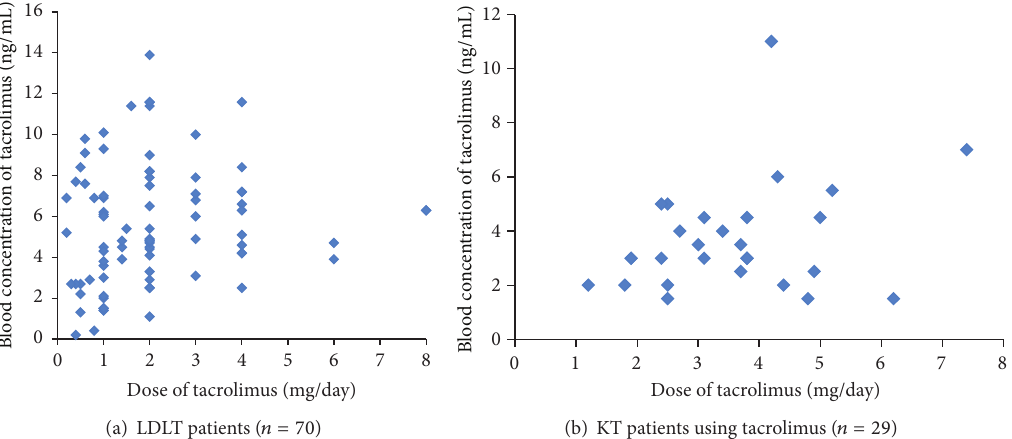
Figure 1: Relationship between the blood concentration of tacrolimus and dose of tacrolimus. There was no statistically significant relationship between the blood concentrations of tacrolimus and the dosage of tacrolimus in LDLT recipients ( 𝑅 = 0.154 , 𝑃 = 0.158 ) (a) and in KT patients who used tacrolimus ( 𝑅 = 0.292 , 𝑃 = 0.1162 ) (b).